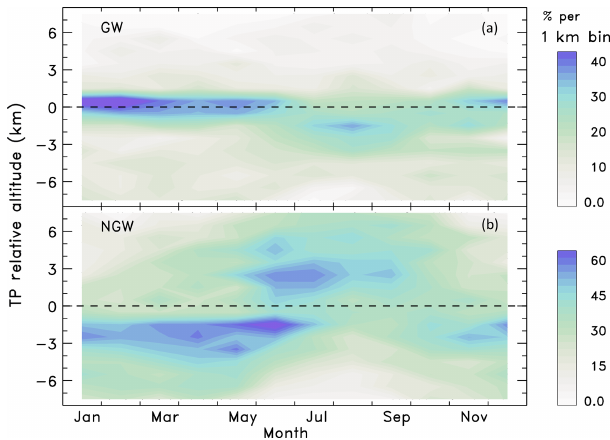
Figure 9. Climatology of ozone laminae frequency at Boulder, CO, as a function of month and altitude relative to the WMO tropopause for GW (a) and NGW (b) laminae. Frequency is expressed as the percent of soundings that contain one or more GW or NGW lam- inae within 1km altitude bins relative to the tropopause. Note the different scales between GW and NGW